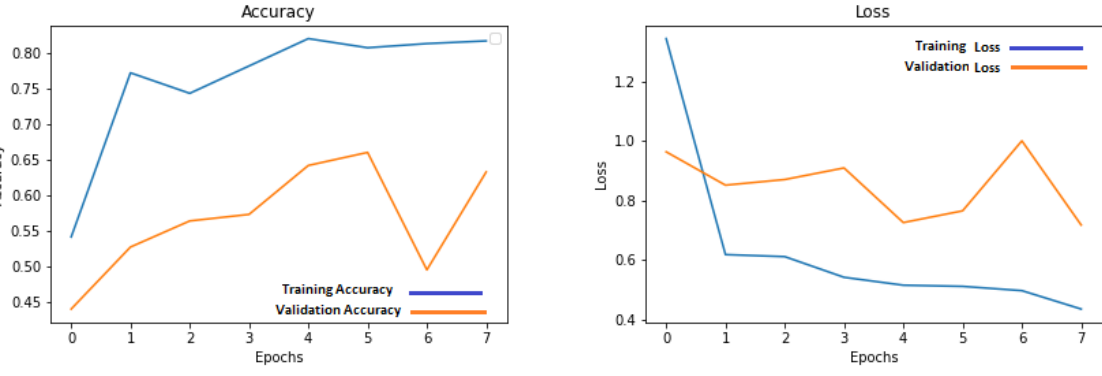
Figure 11. Accuracy and loss graphs for training and validation on high-resolution images.